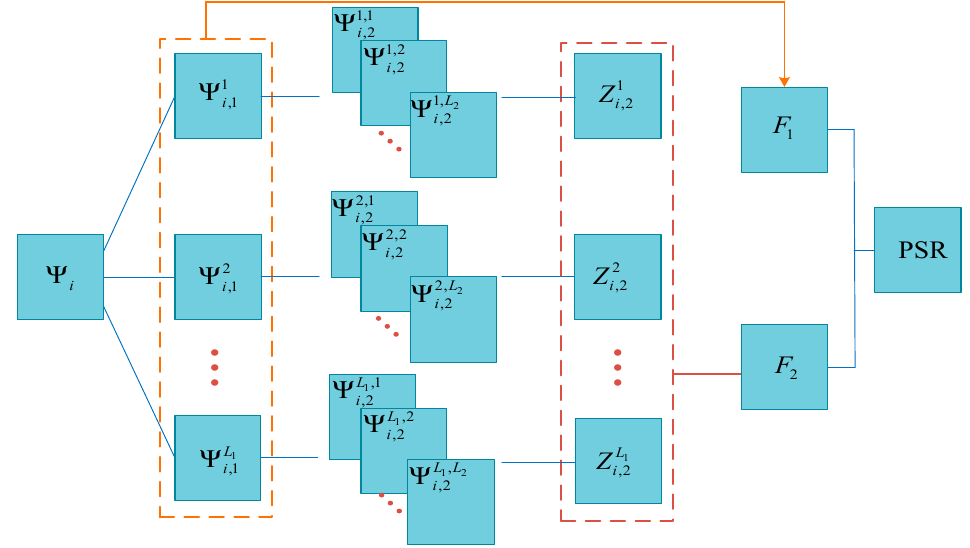
Figure 2. Scheme for constructing a PCANet-based structural representation (PSR) by using the multilevel features produced by PCANet.